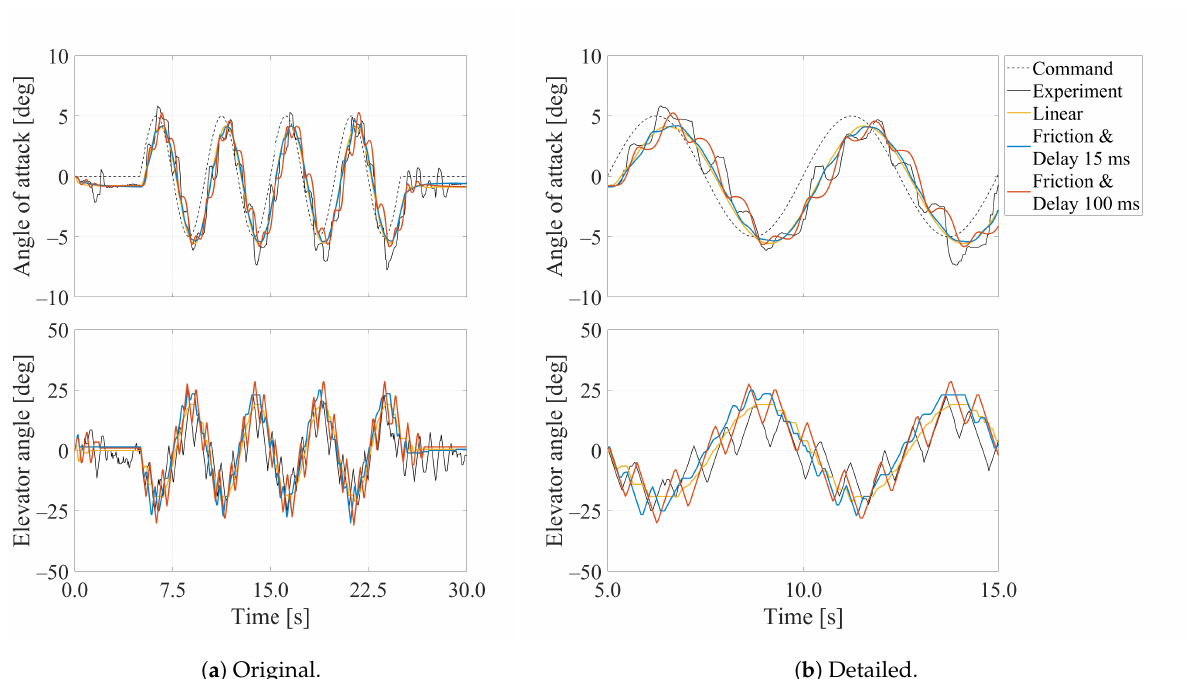
( a ) Original. ( b ) Detailed. Figure 10. Simulated pitch control results for NN50 with sinusoidal command at wind speed of 20 m/s ( a ). Time range 5.0s–15.0s is magnified in ( b ).